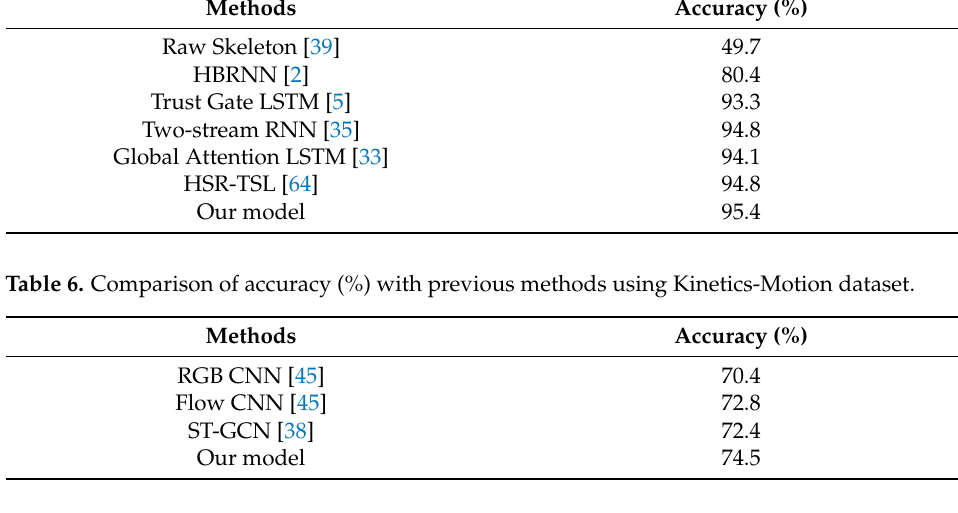
Table 7. Comparison of action recognition accuracy (%) with previous methods using UCF- Motion dataset.